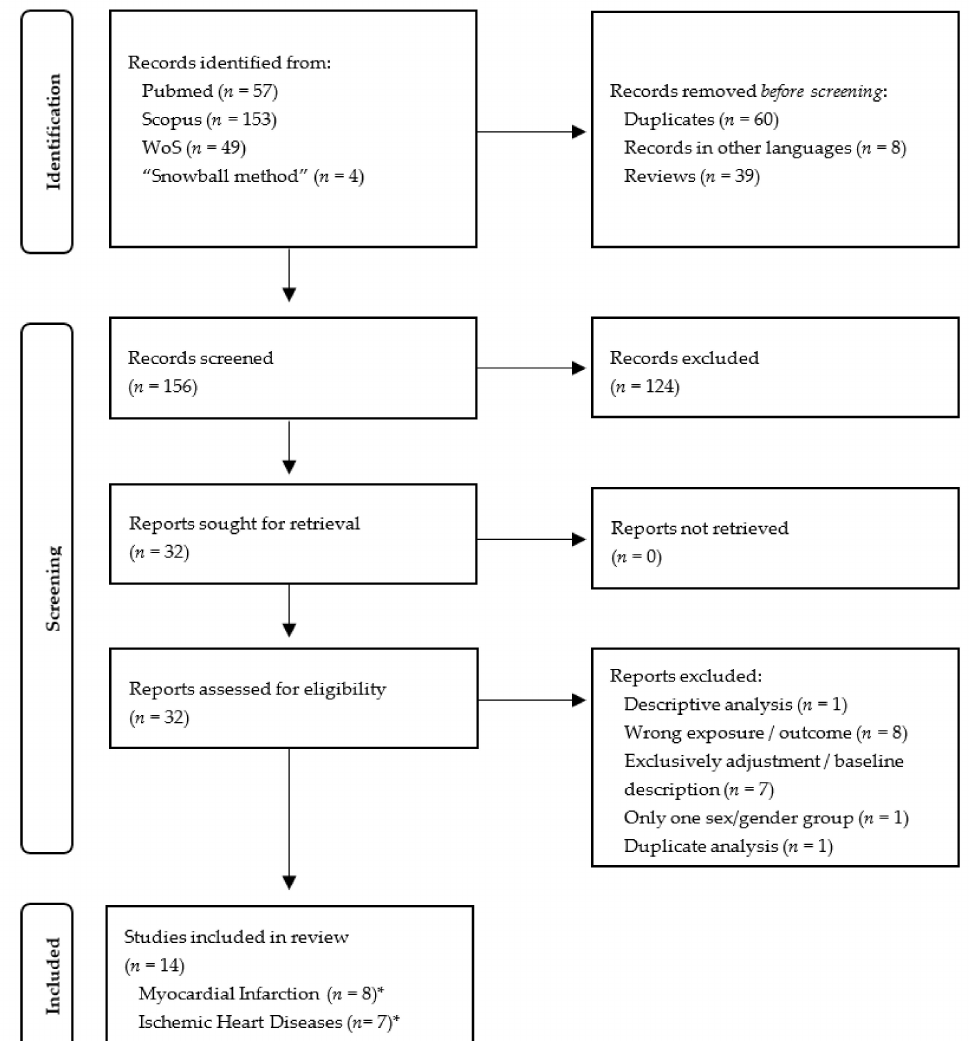
Figure 2. PRISMA Flow Diagram of the selection process of records regarding ischemic heart diseases and myocardial infarction. * One study investigated both outcomes ischemic heart diseases and myocardial